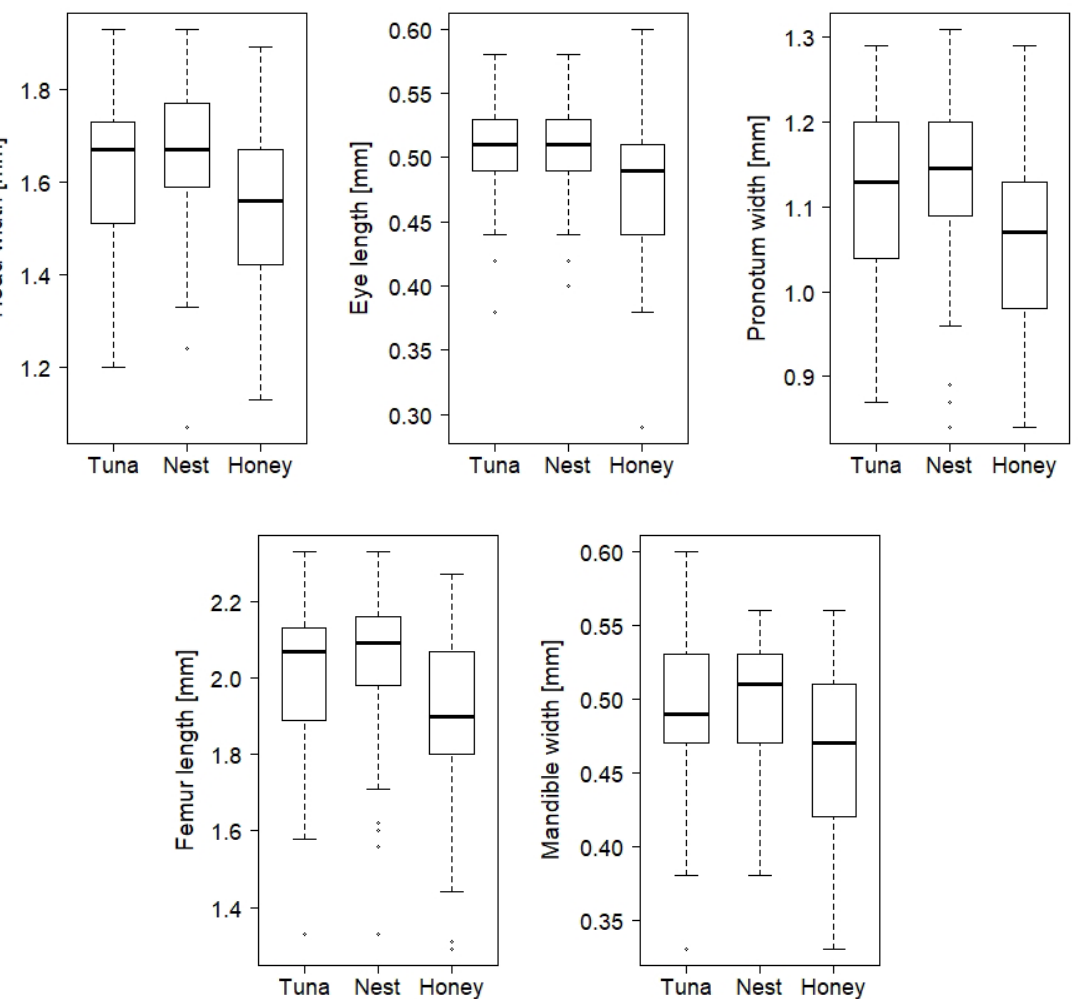
Fig 2. Overview of measured dimensions (head, pronotum and mandible width, femur and eye length) of Formica polyctena workers in dependence on their work division (tuna – workers gathering protein food, honey - workers collecting honeydew, nest – workers at the upper parts of nests). Horizontal line in the middle of the box is median, whiskers represent 1.5 times the inter-quartile range. One hundred workers were used for measurement in every